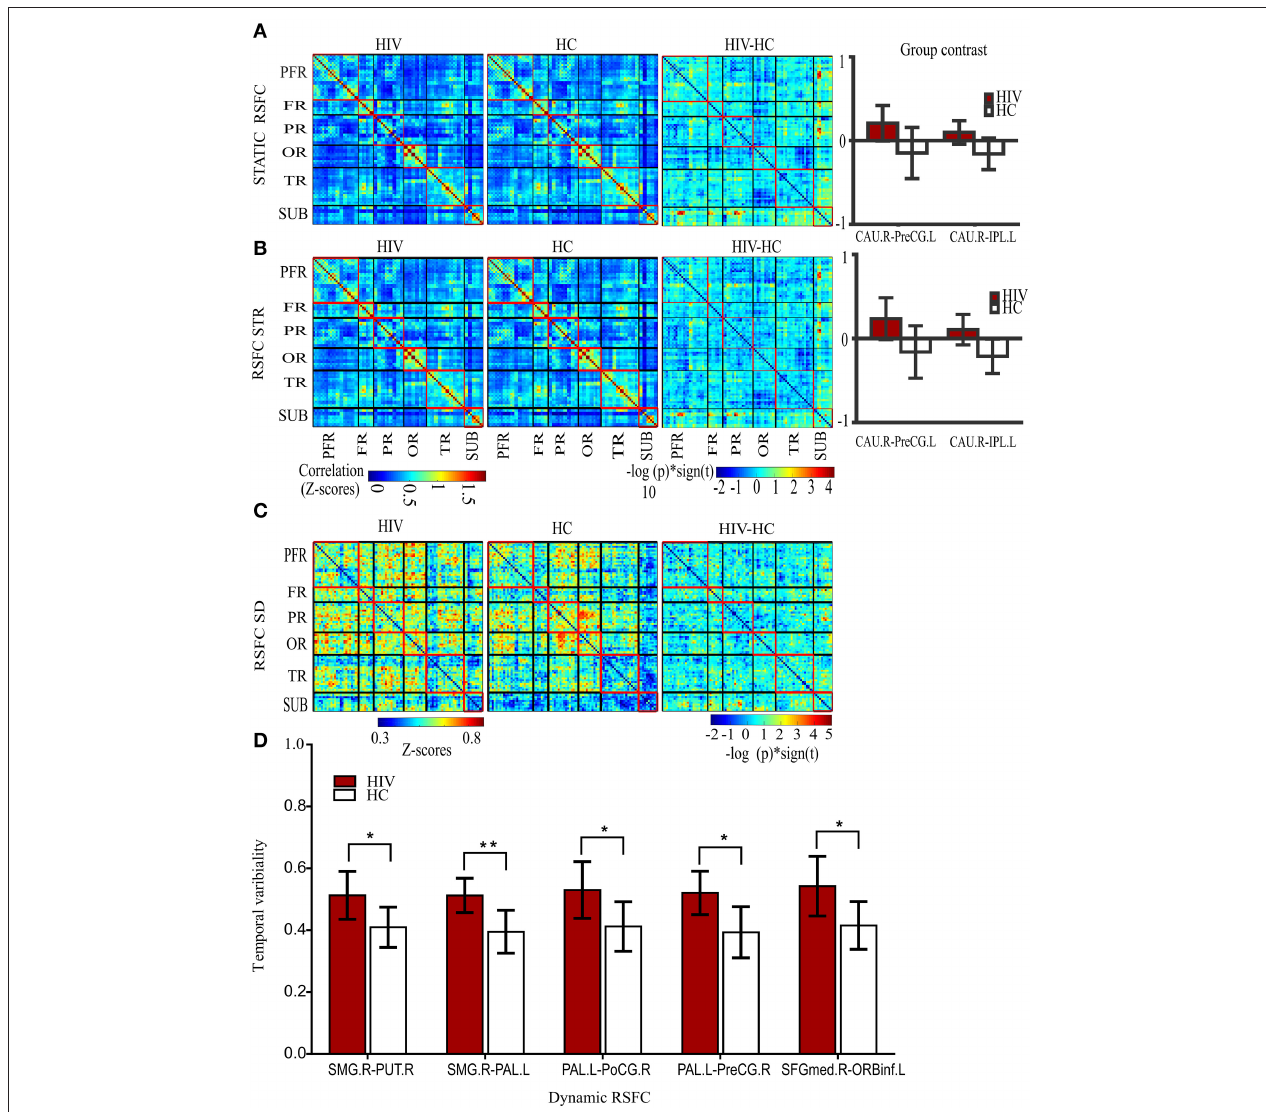
FIGURE 2 | Static and dynamic functional connectivity. (A) The static RSFC maps for HIV and HC groups, group difference map (HIV-HC), and between-group contrast. (B) The average dynamic RSFC maps for HIV and HC groups, group difference maps (HIV-HC), and between-group contrast in average dynamic RSFC. (C) The mean dynamic temporal variability maps for HIV and HC groups, and group variability-difference maps (HIV-HC). (D) The group difference for temporal variability as depicted in the histogram. PFR, prefrontal regions; FR, other frontal regions; PR, parietal regions; OR, occipital regions; TR, parietal regions; and SUB, subcortical regions. R, right; L, left; CAU, the caudate nucleus; IPL, inferior frontal lobe; and PreCG, precentral gyrus; SMG, supramarginal gyrus, PUT, putamen; PAL, pallidum; PoCG, postcentral gyrus; SFGmed; superior frontal (medial) gyrus; ORBinf, the pars of orbitalis of the inferior frontal gyrus. Pearson’s correlation coefficients were all fisher’s z-transformed. The group-difference (HIV-HC) connectivity maps are displayed as –log10 ( p -value) × sign ( t